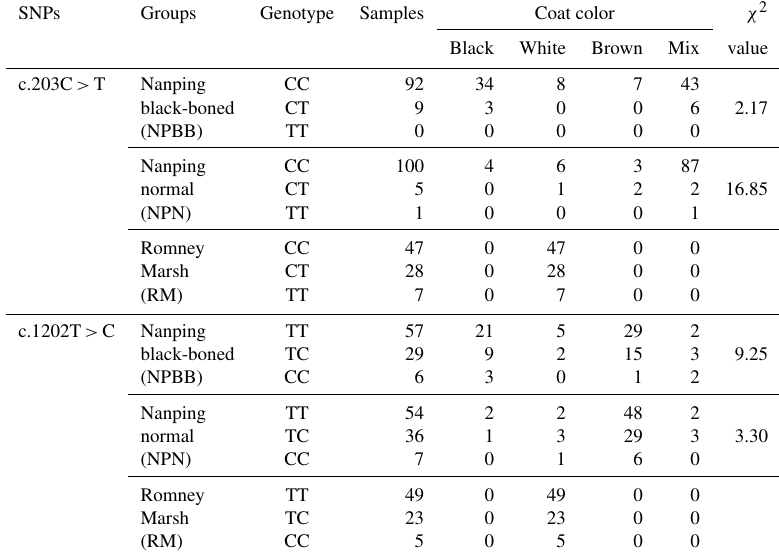
Table 3. The TYRP1 genotype with coat color distribution in the three groups of sheep.